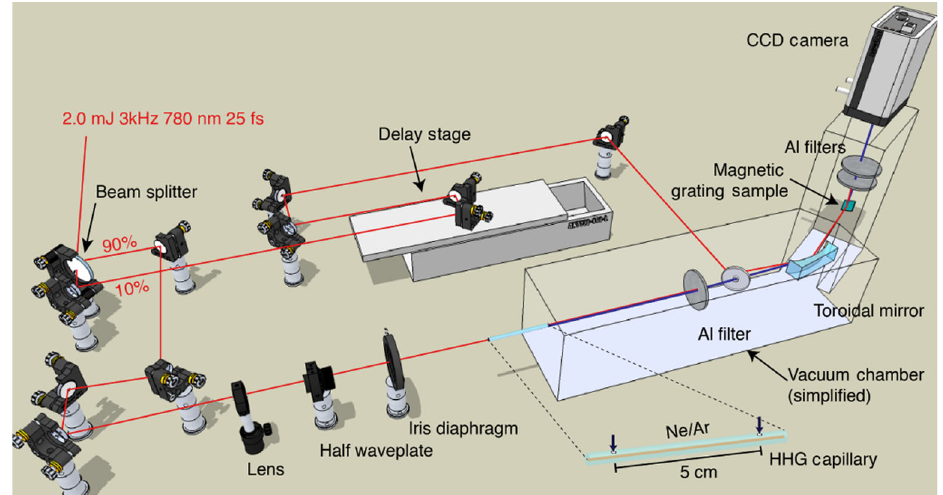
FIG. 1. Experimental setup. The magnetic grating sample is excited by a 25-fs pump pulse and then probed by a time-delayed HHG probe pulse. To spectrally resolve the XUV spectra, the grating sample diffracts the probe beam that is detected by use of a CCD camera. The optical models are from Ref.